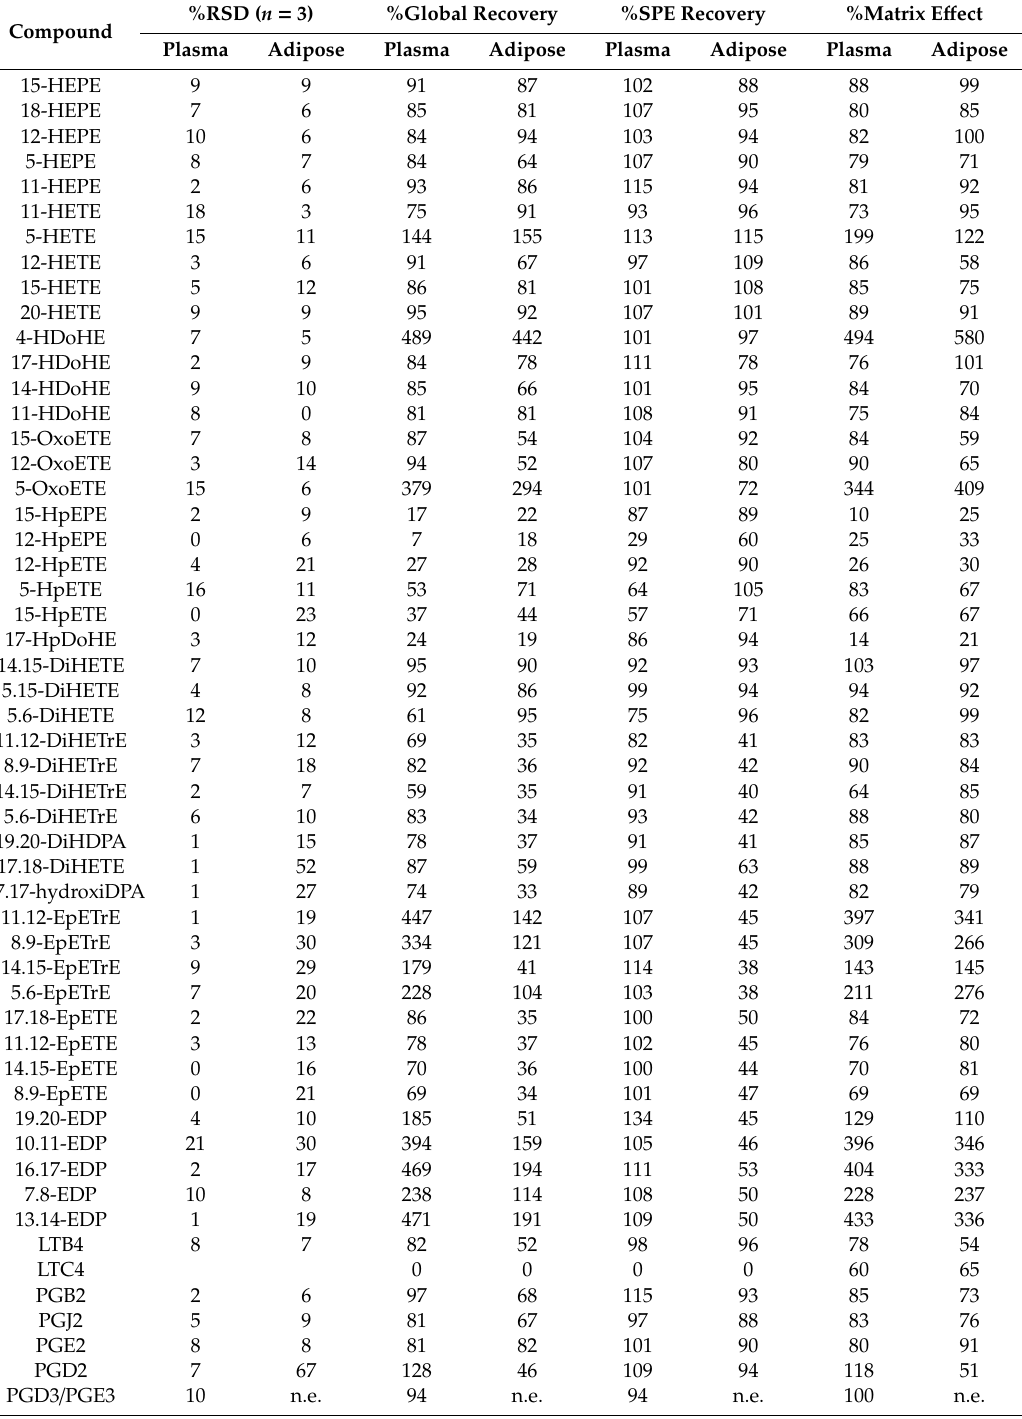
Table 2. Repeatability of the SPE-LC-MS assay. Global Recovery (SPE-LC-MS). Extraction recovery (SPE) and matrix e ff ect (LC-MS) for spiked plasma and adipose tissue samples ( n = 3). n.e.